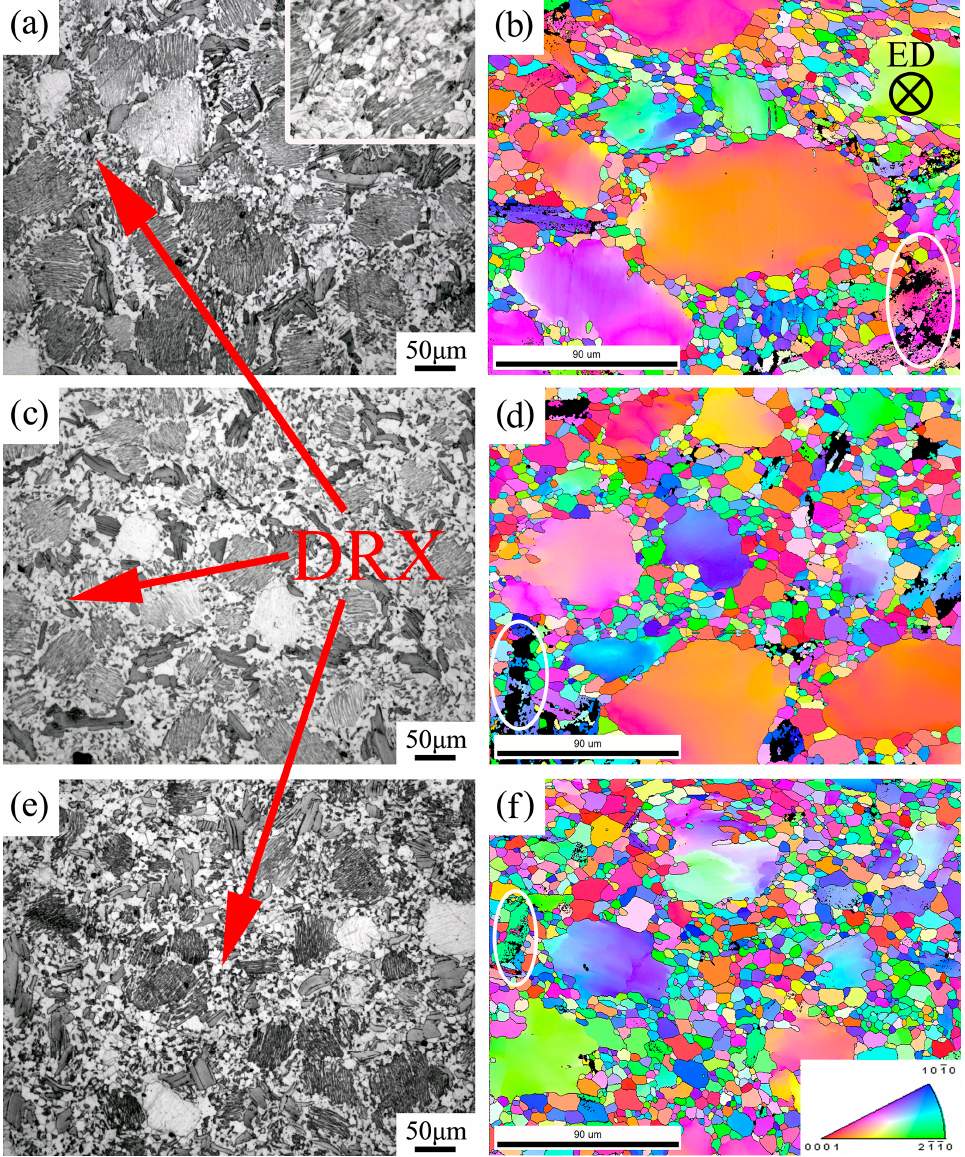
Figure 7. Microstructure observations obtained from the transverse cross-sections of the RUE-formed Mg-12.0Gd-4.5Y-2Zn-0.4Zr alloy: ( a , b ) one pass; ( c , d ) two passes; ( e , f ) three passes; ( a , c , e ) OM images; and ( b , d , f ) electron backscattered diffraction (EBSD) orientation maps. The color key triangle shows the crystallographic orientation of hcp crystal.